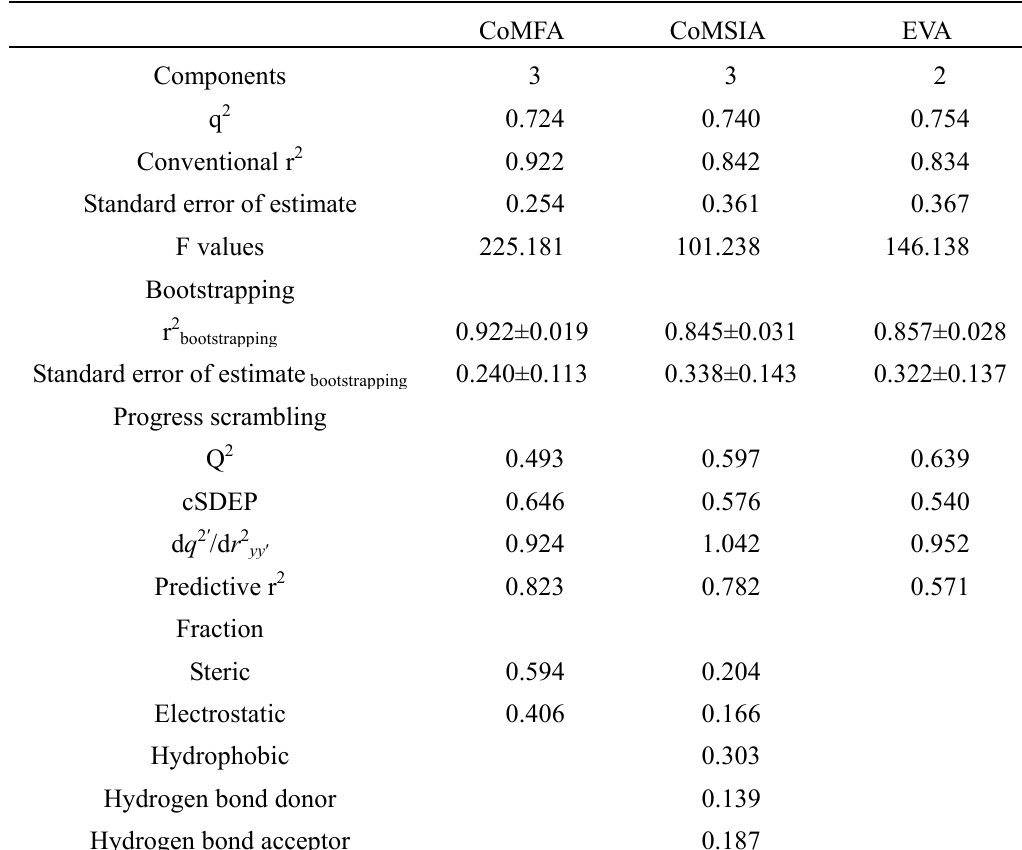
Table 1. Summary of 3D-QSAR